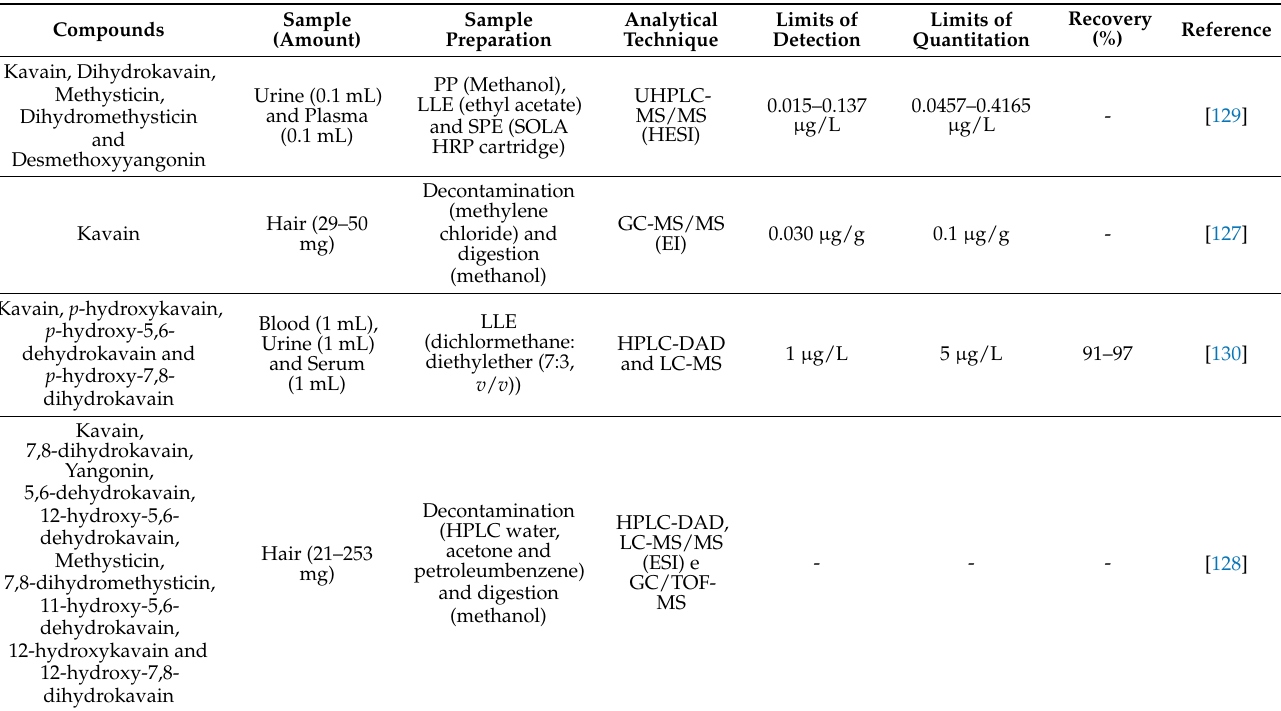
Table 6. Analytical methods for the determination of the main components of Piper methysticum